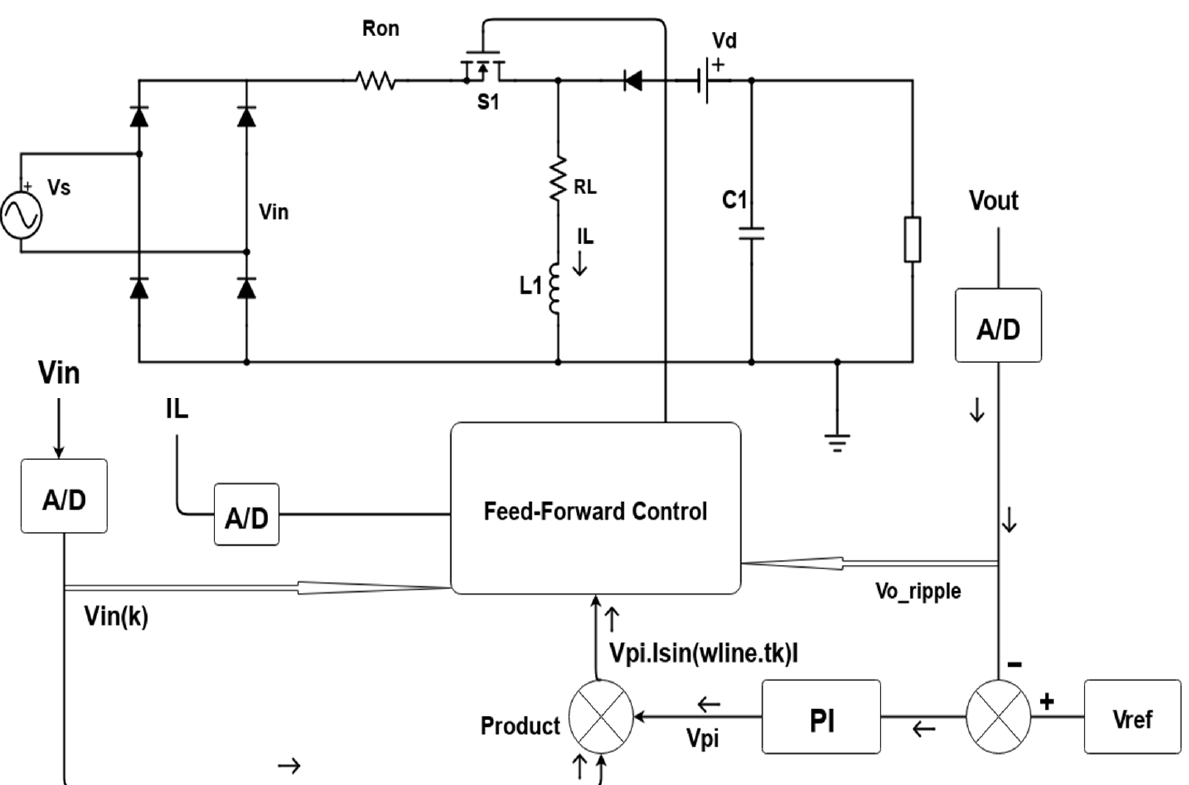
Figure 5. Buck ‐ boost PFC with feed ‐ forward control algorithm. Figure 5. Buck-boost PFC with feed-forward control